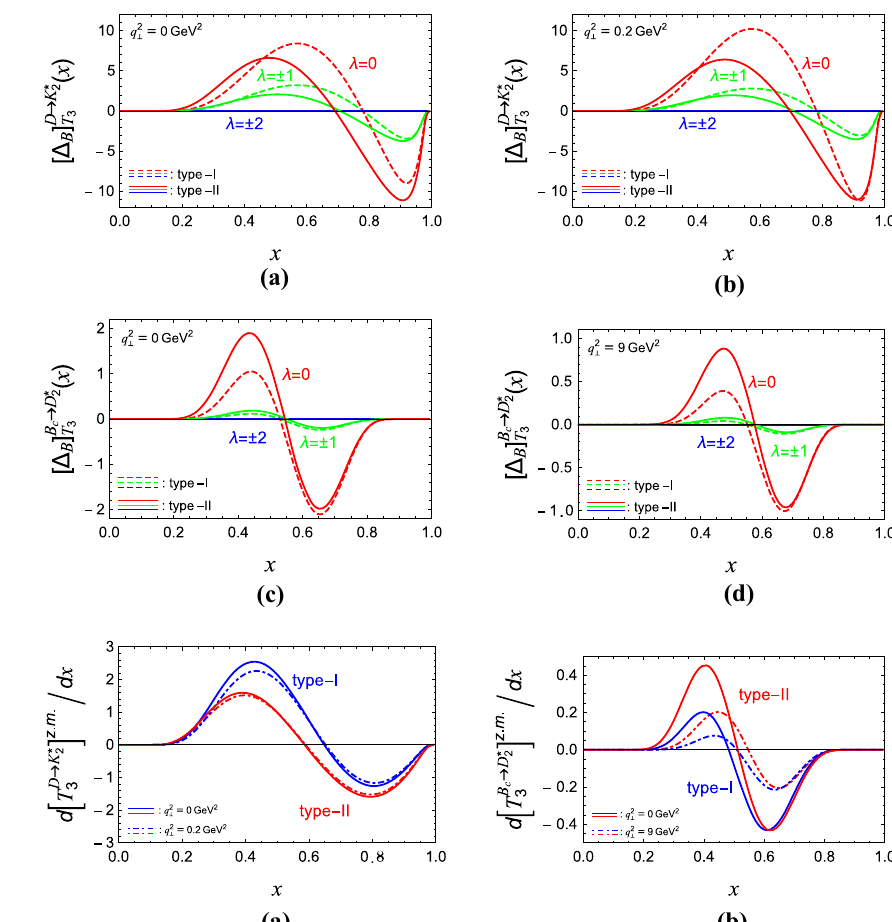
Fig. 2 The dependences of [ (cid:22) ] ( x ) on x for D → K ∗ B T 3 2 transition at q 2 ⊥ = ( 0 , 0 . 2 ) GeV 2 and for B c → D ∗ transition at 2